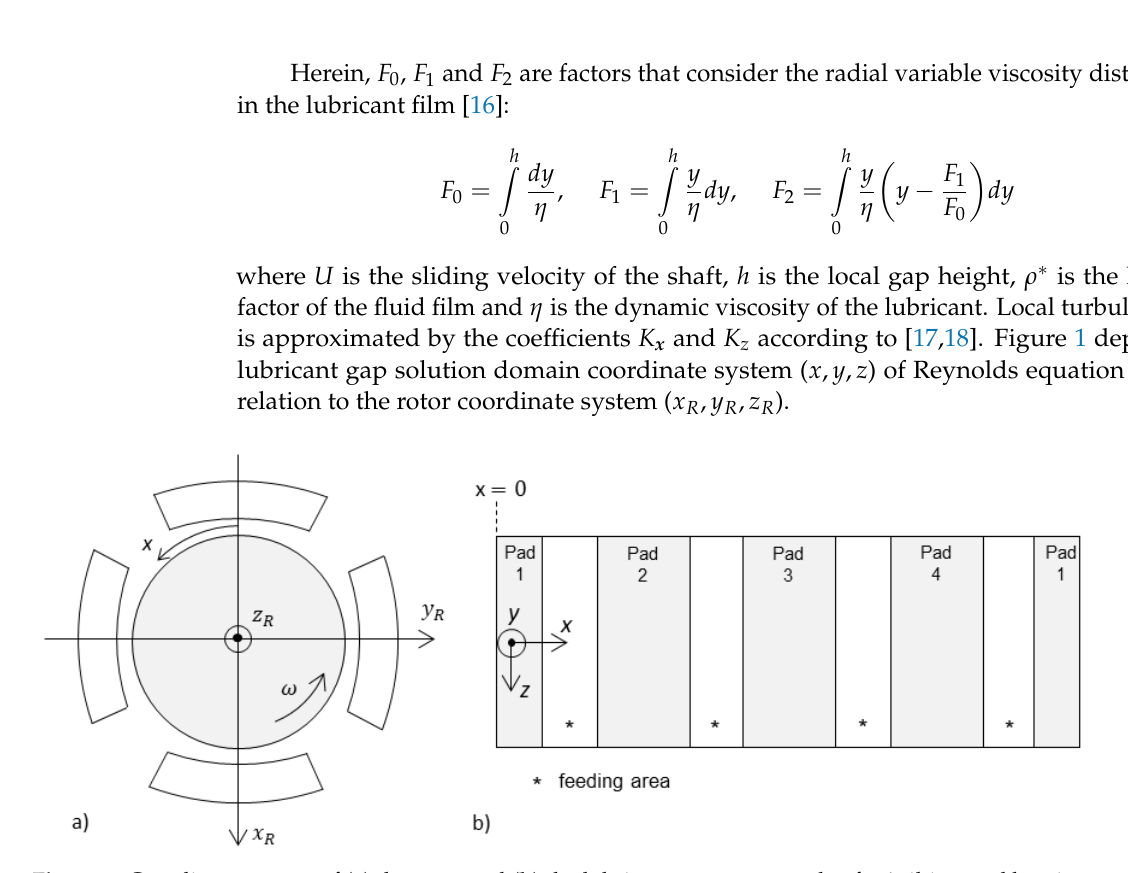
Figure 1. Coordinate system of ( a ) the rotor and ( b ) the lubricant gap on example of a 4-tilting-pad bearing. A mass conserving algorithm based on JFO theory is used for solving Reynolds equation [19]. The algorithm described in [19] for the stationary case is extended for the consideration of the time dependency of the instationary case, for example [20]. The viscosity factors can be derived from solution of the three-dimensional energy equations considering the dissipation by friction, heat transfer in the oil film and heat conduction in journal and pads. The temperature distribution is calculated for a centered journal position for different rotor speeds at stationary rotation. A more comprehensive description of the theoretical models, in particular the energy equation can be found in [21,22]. Pad movability is predicted by solving the pad’s equations of motion for transversal and tilting directions. Figure 2 shows the pad coordinate system ( ζ , η , θ ) for a description of the transversal equations of motion.